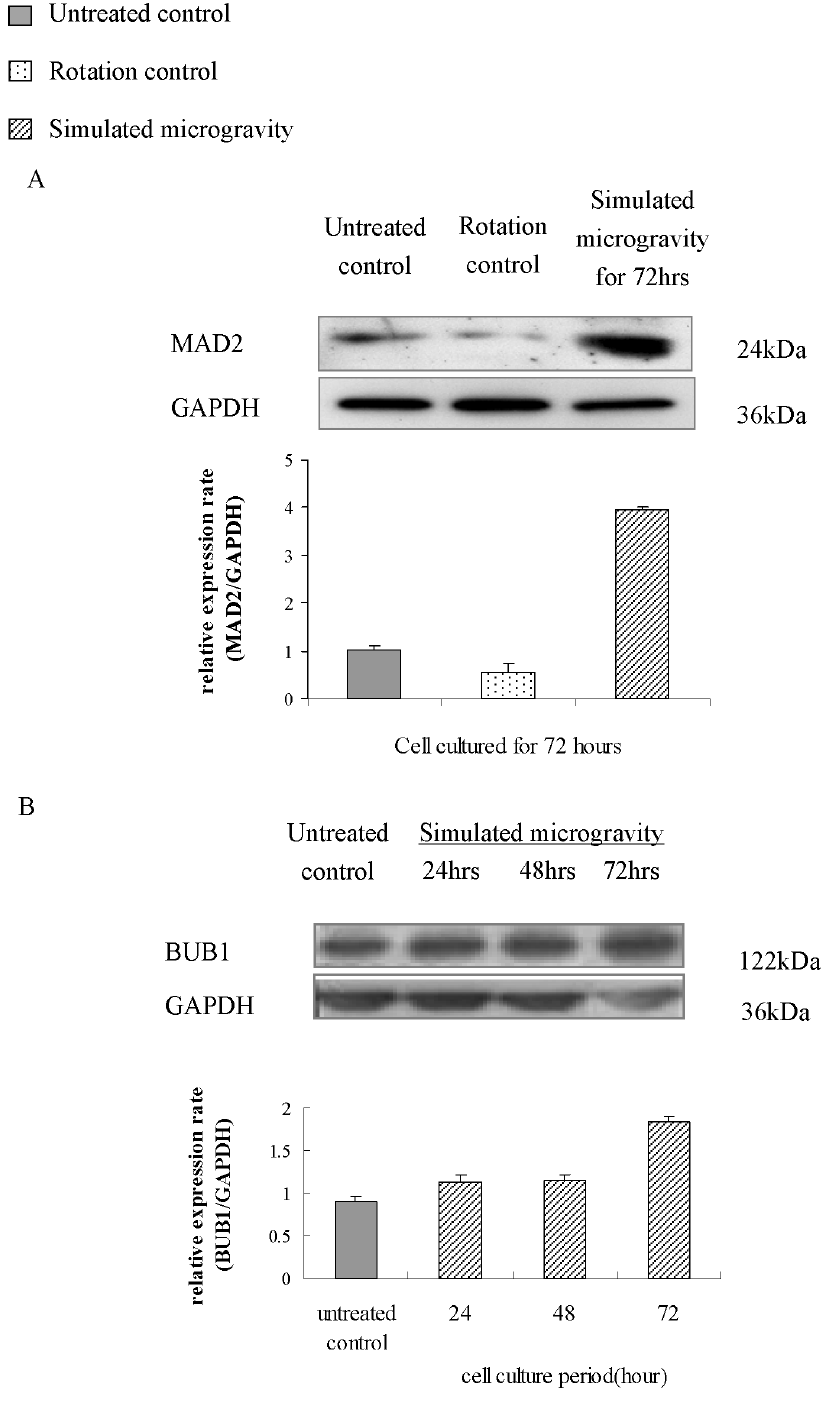
Figure 8. Results of Western Blot analysis of MAD2 in MG-63 cells after 72-hour cultivation and of BUB1 in MG-63 cells after 24, 48 and 72-hour cultivation under simulated microgravity. After MG-63 cells are treated with simulated microgravity for 72 hours, MAD2 and BUB1 expression increase to 3.9-fold (A) and 2-fold (B) as compared with untreated control. The relative expression rate shown represent the mean 6 S.E.